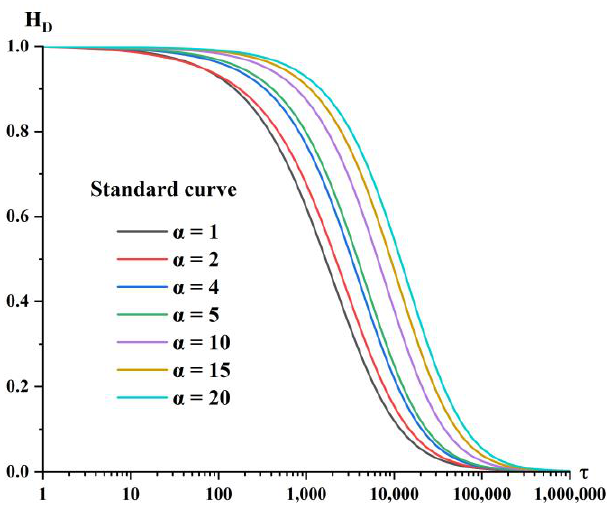
Figure 2. HWS model standard curve.